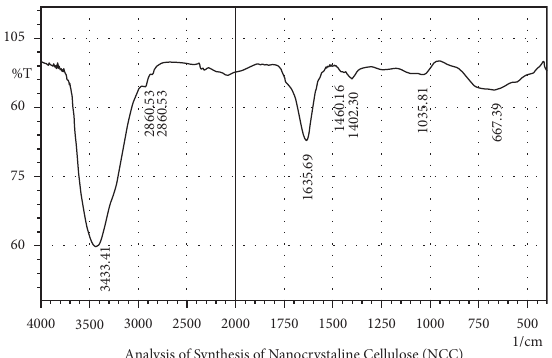
Figure 3: The results of the analysis of nanocrystalline cellulose (NCC) using